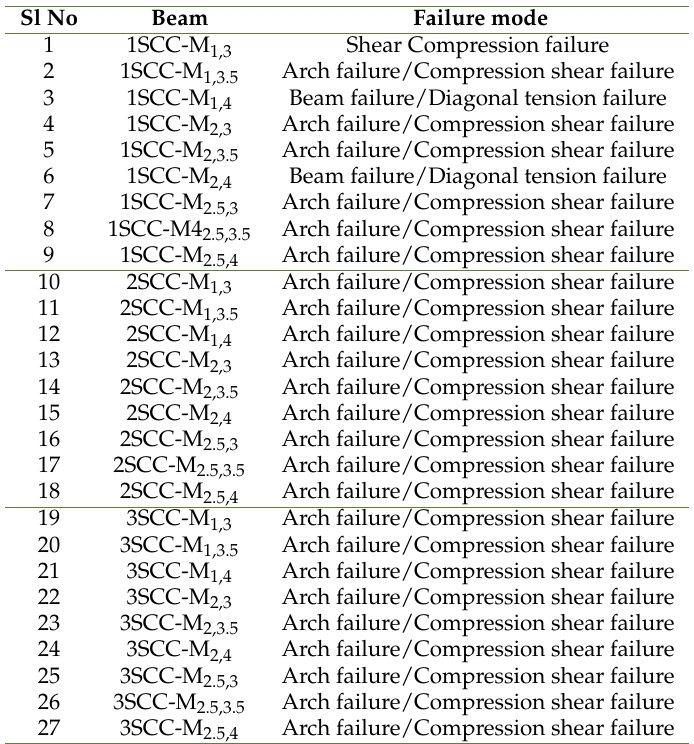
Table 5. Details of selected mix